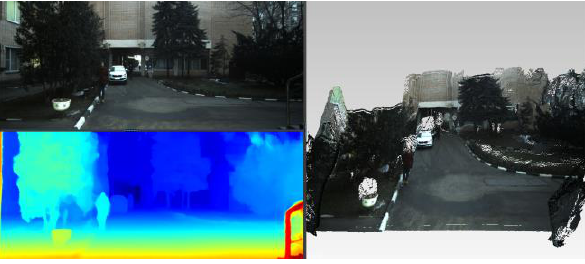
Figure 3 . The result of the dense stereo reconstruction algorithm.